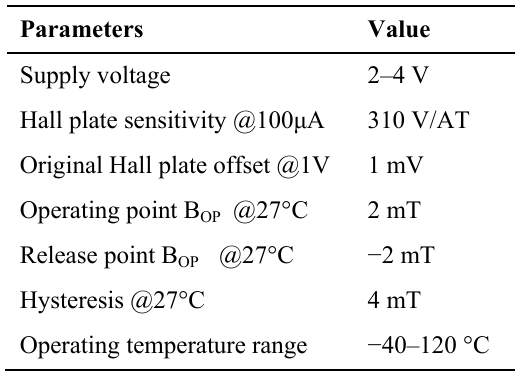
Table 2. Typical characteristics of Hall sensor